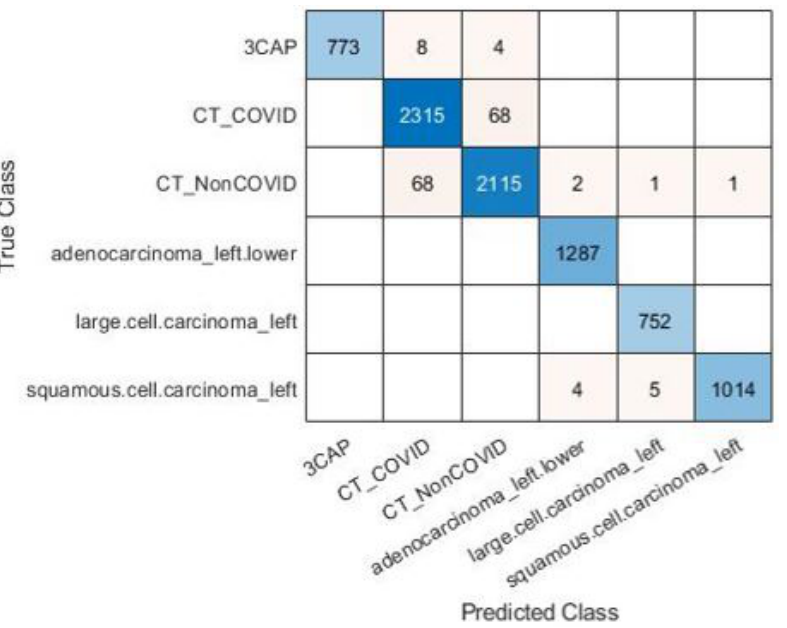
Figure 13. Confusion matrix for InceptionResNetv2 model with image SR using dataset #3.